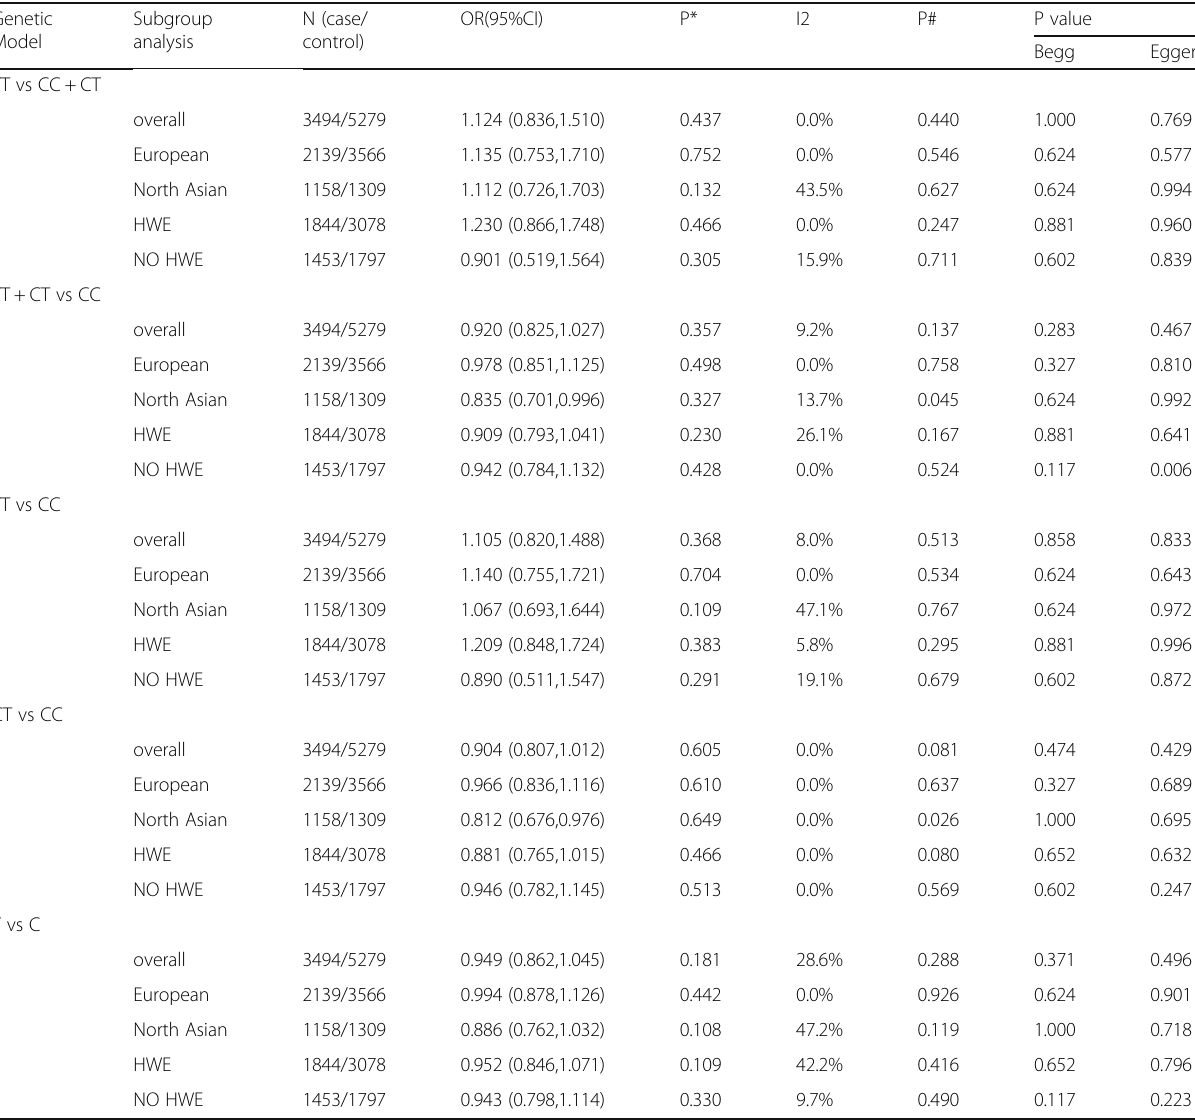
Table 4 Meta-analysis of TNF- α 857C/T polymorphisms and CAD susceptibility Genetic Subgroup Model